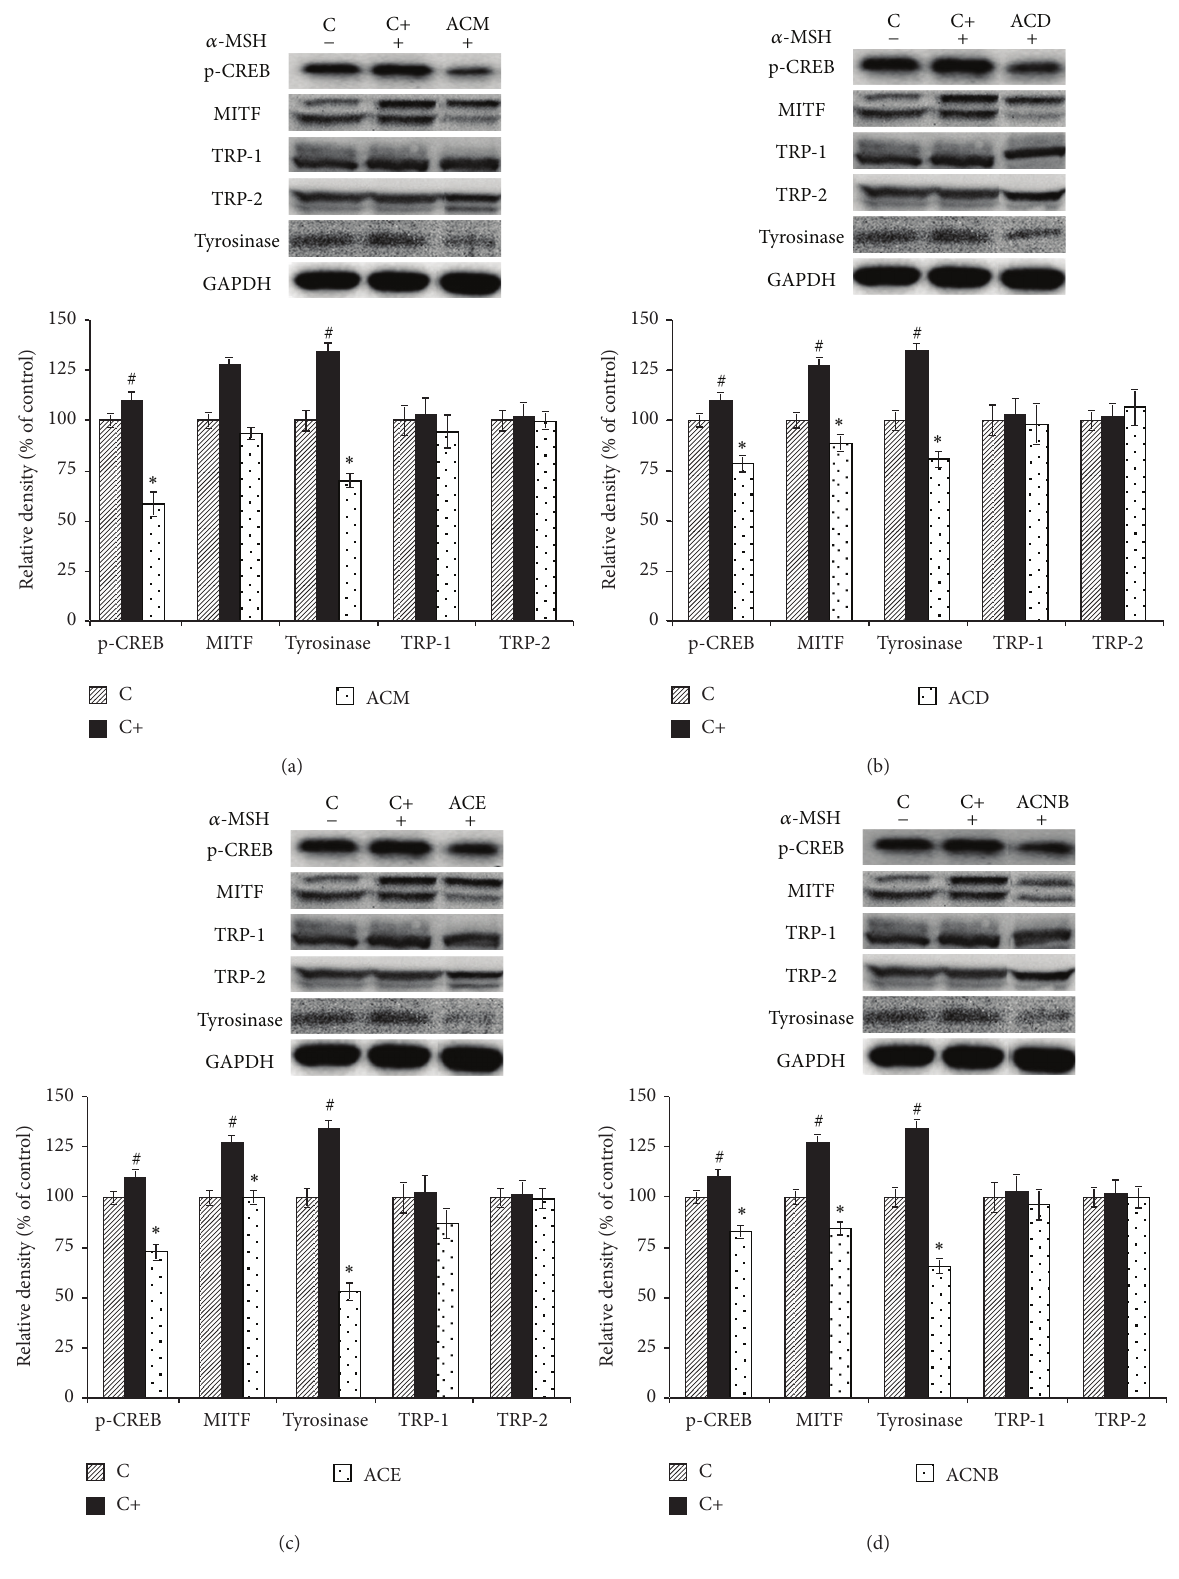
Figure 3: A. Communis extract and its different partition extracts downregulate the expression of MITF, p-CREB, and tyrosinase. The B16F10 cells were treated with different extracts (a) ACM, (b) ACD, (c) ACE, and (d) ACNB. # 𝑃 < 0.05 indicates significant difference from control in the absence 10nM of 𝛼 -MSH; ∗ 𝑃 < 0.05 indicates significant difference from 𝛼 -MSH treatment